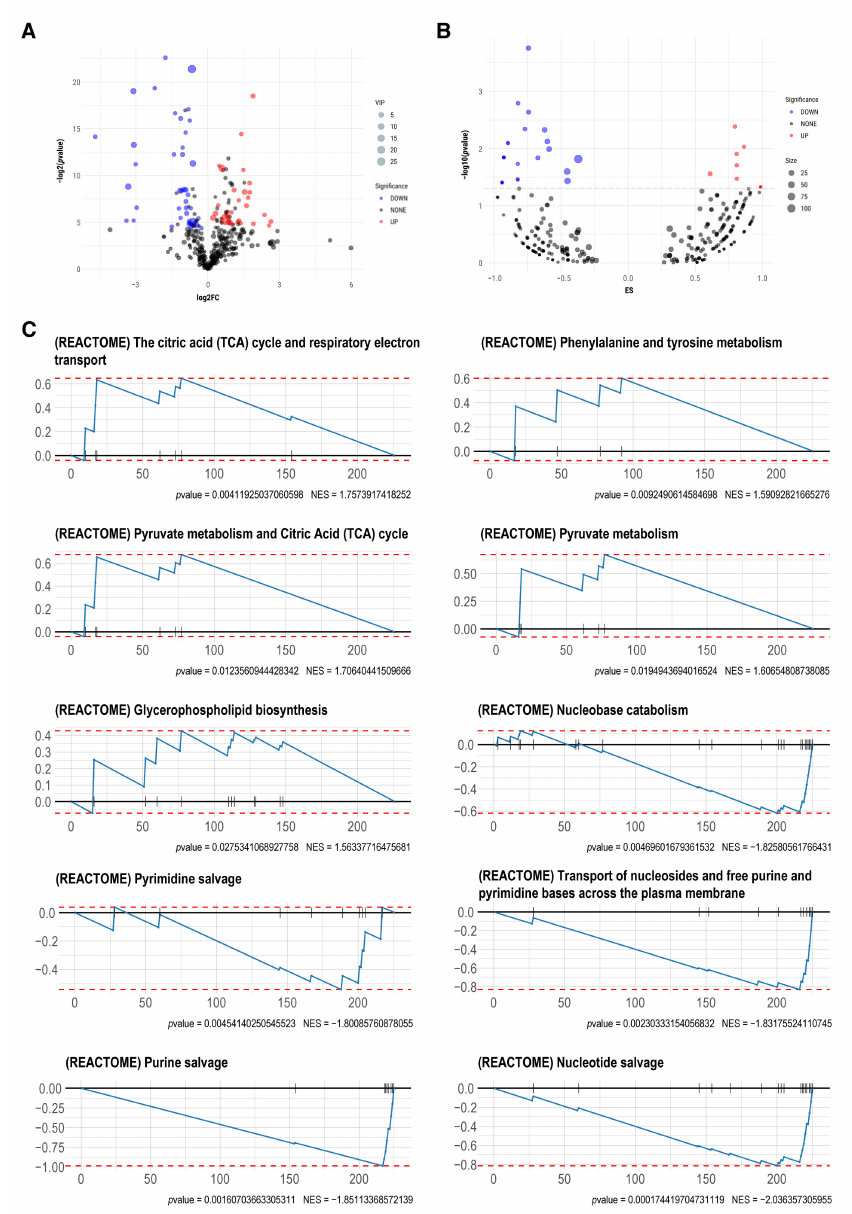
Figure 4. Differential metabolite analysis and MSEA. ( A ) Volcano plot of significantly different metabolites. Red represents a significant increase in abundance, green represents a significant decrease in abundance, and black represents no significant change in abundance. The size of dots represents the VIP of metabolites. ( B ) Volcano plot of metabolite set enrichment analysis (MSEA) on basis of the Reactome database. Red and blue represent pathways mainly enriched by metabolites with increased or decreased abundance, respectively. Black represents pathways enriched by metabolites with no significant alteration. For visualization purposes, − log10 ( p -value) greater than 6 was defined as equal to 6. ( C ) Enrichment plots for top five pathways mainly composed of metabolites with increased or decreased abundance based on the p